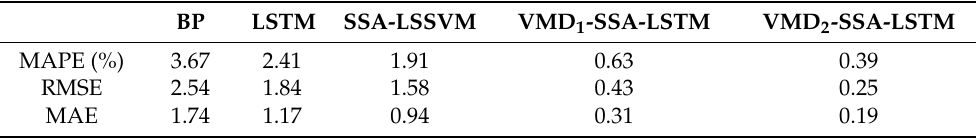
Figure 6. NSW prediction result curve. Table 1. Error metrics for different prediction models in NSW.